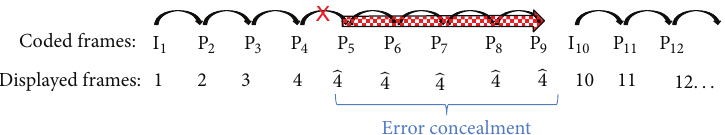
Figure 1: Error concealment